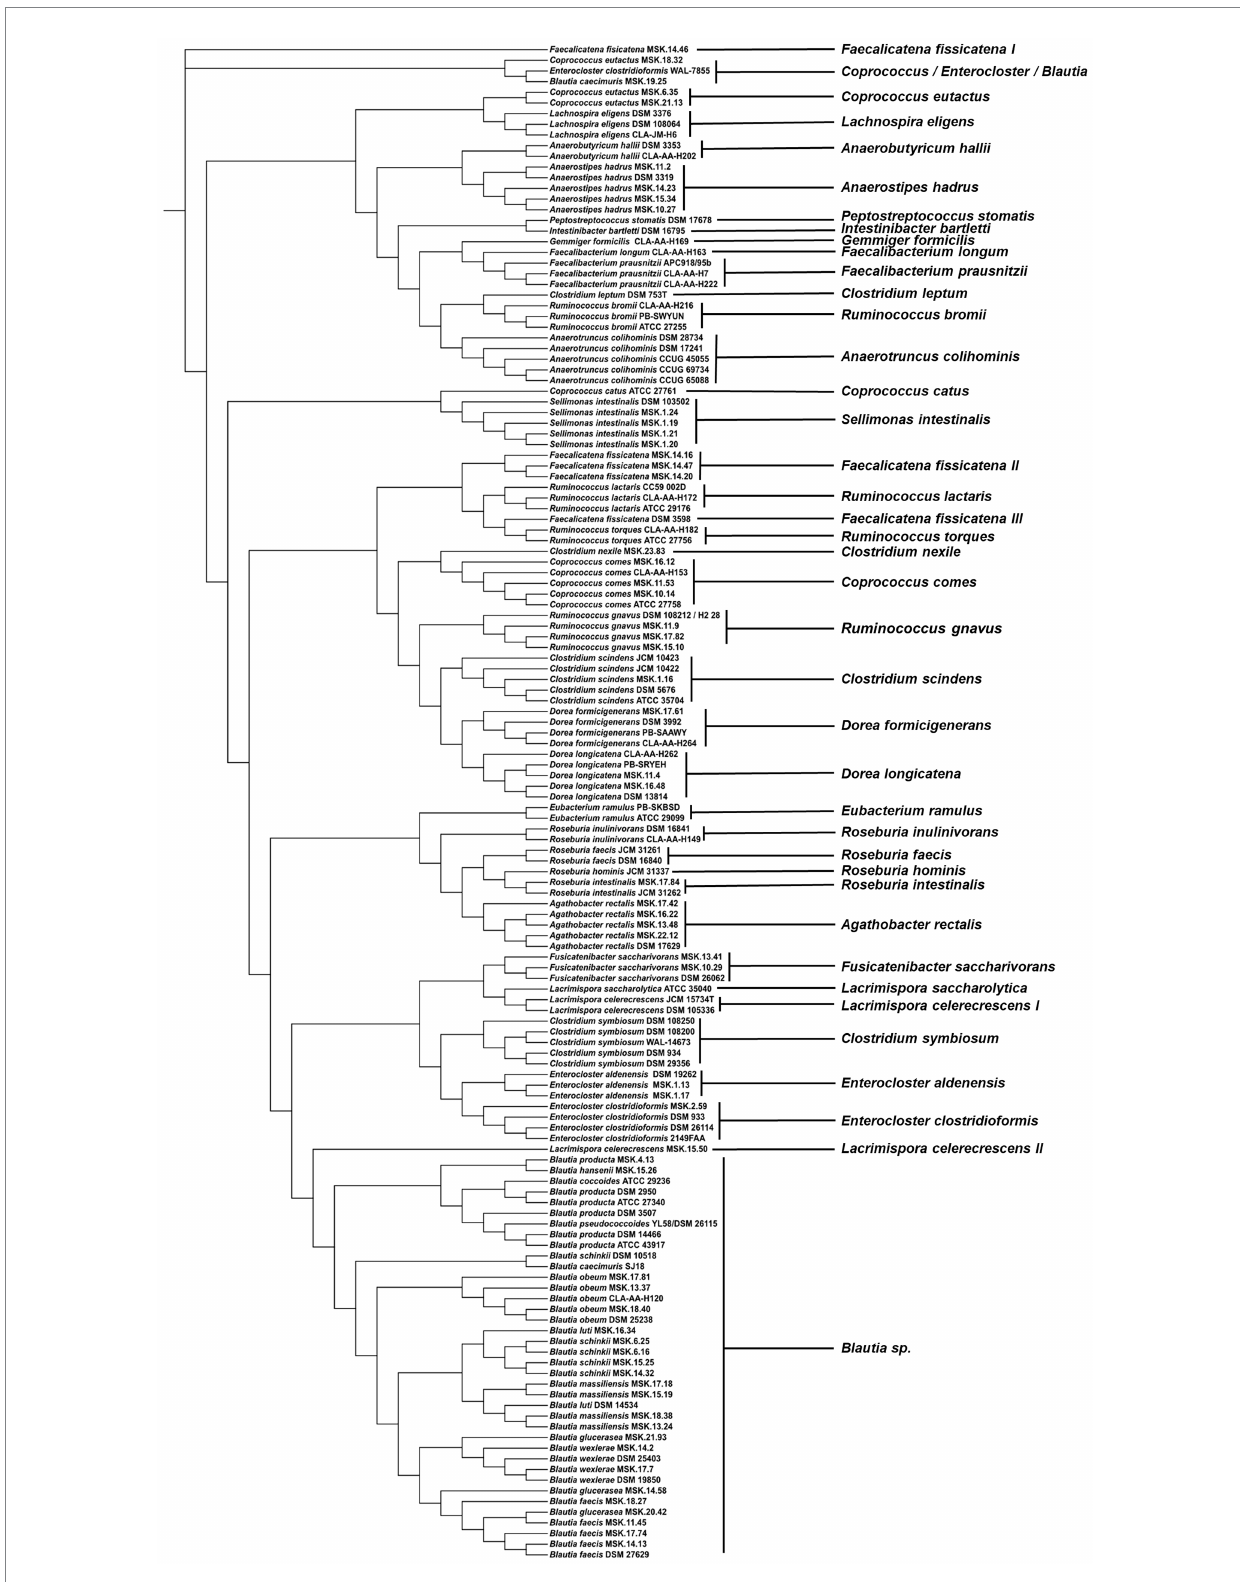
FIGURE 4 Maximum-likelihood phylogenetic tree based on complete 16S rRNA gene sequences of the strains used in the construction of CLOSTRI-TOF